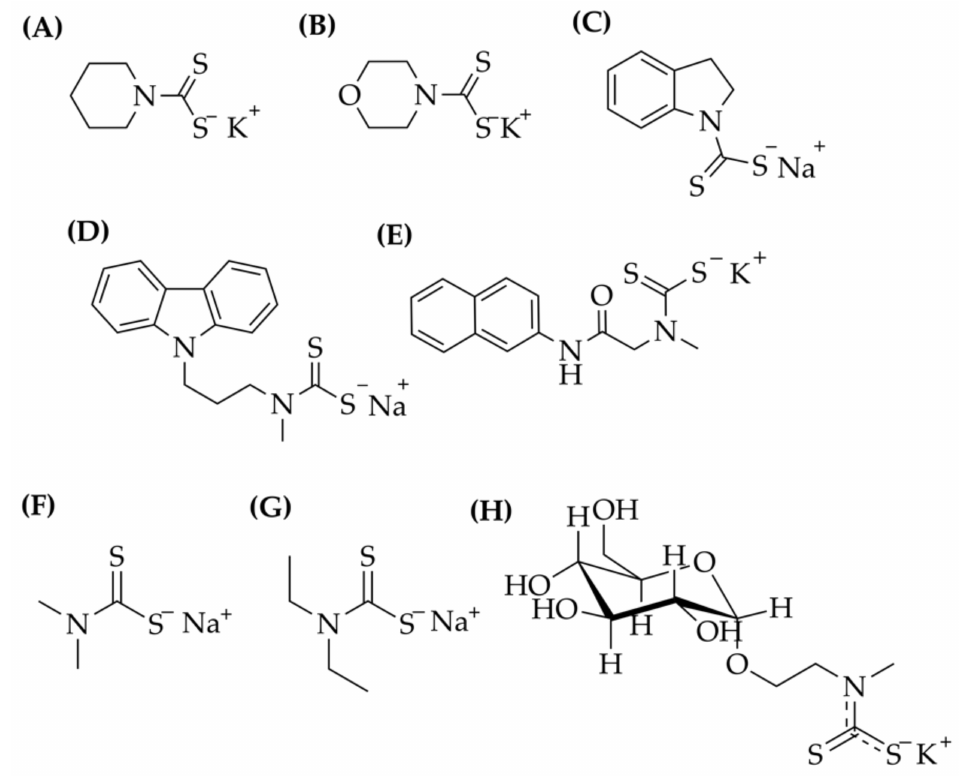
Figure 4. Chemical structures of the dithiocarbamates explored in this work: ( A ) piperidine dithiocar- bamate potassium salt (K(pipeDTC)); ( B ) morpholine dithiocarbamate potassium salt (K(morphDTC)); ( C ) Indoline dithiocarbamate sodium salt (Na(indolineDTC)); ( D ) N-methyl-N-propyl-carbazole dithiocarbamate sodium salt (Na(Carbz-pr-N(Me)-DTC)); ( E ) β -sarcosine-naphtalene dithiocarba- mate potassium salt (K( β -Napht-Sar-DTC)); ( F ) dimethyl dithiocarbamate (DMDT); ( G ) Diethyl dithiocarbamate (DEDT); and ( H ) β -D-glucoside-conjugated dithiocarbamate